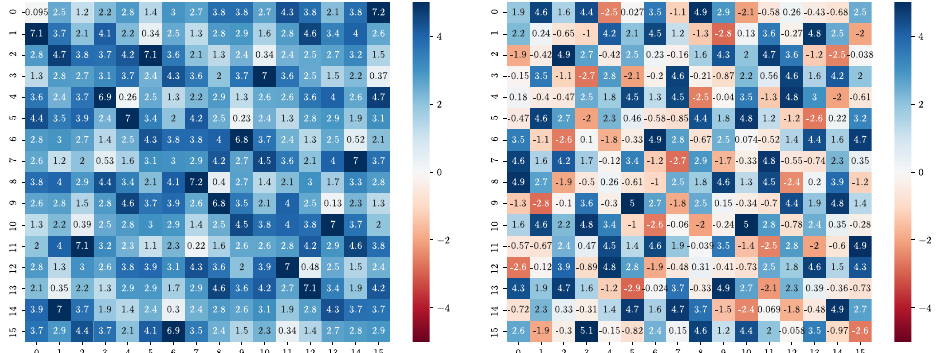
Figure 18: Experimental index-dependent means from 50 experiments (random keys and 2 23 δ -sets) on Small- AES with ( right ) its original S-box and ( left ) the PRESENT S-box. Values are multiplies of σ deviations from the mean of the PRP. The cell positions x, y represent the active plaintext cell ( y -axis) and the tested ciphertext cell ( x -axis) after four rounds without the final MixColumns operation.